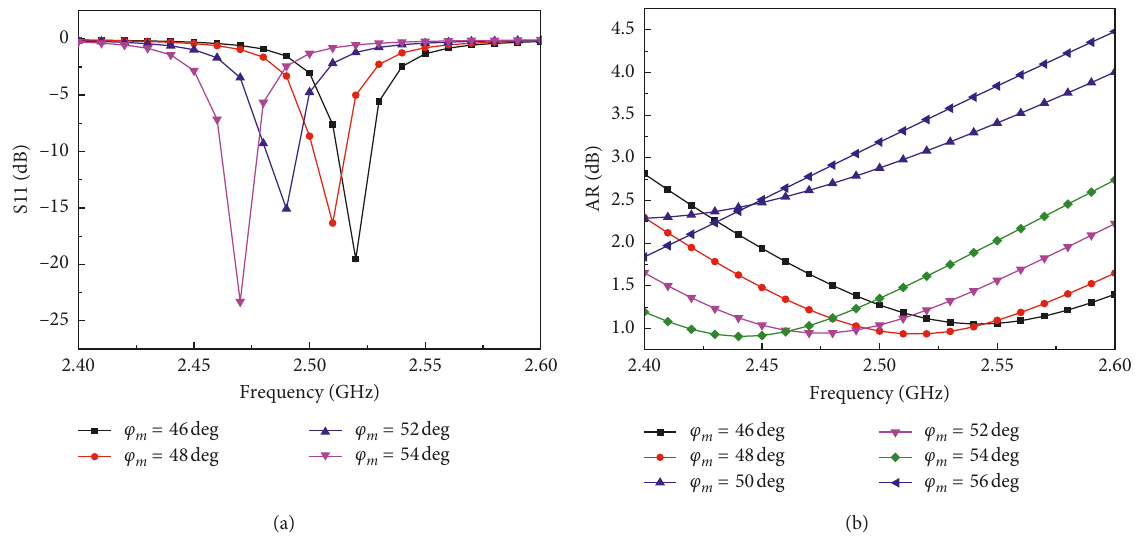
Figure 6: Effect of different φ m on antenna’s performance: (a) S11 and (b)